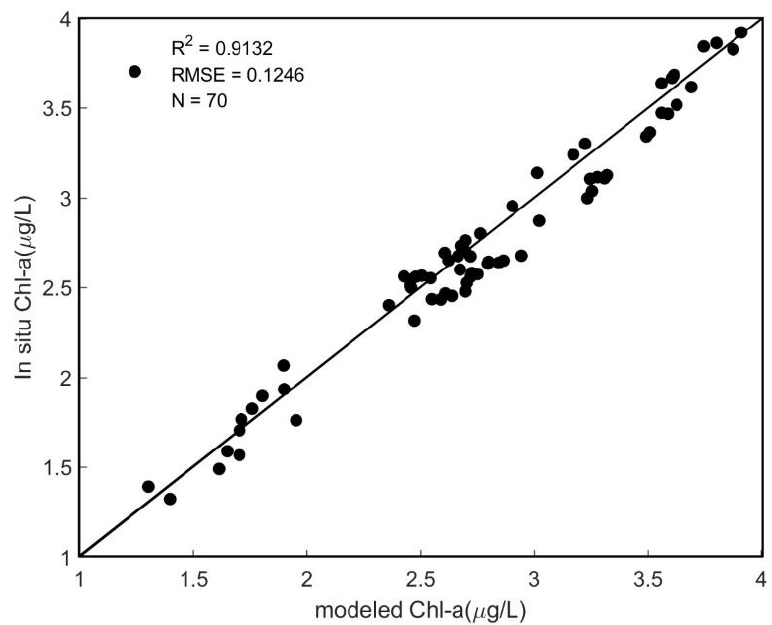
Figure 4. Comparison of modeled Chl-a concentration value and in situ Chl-a value.